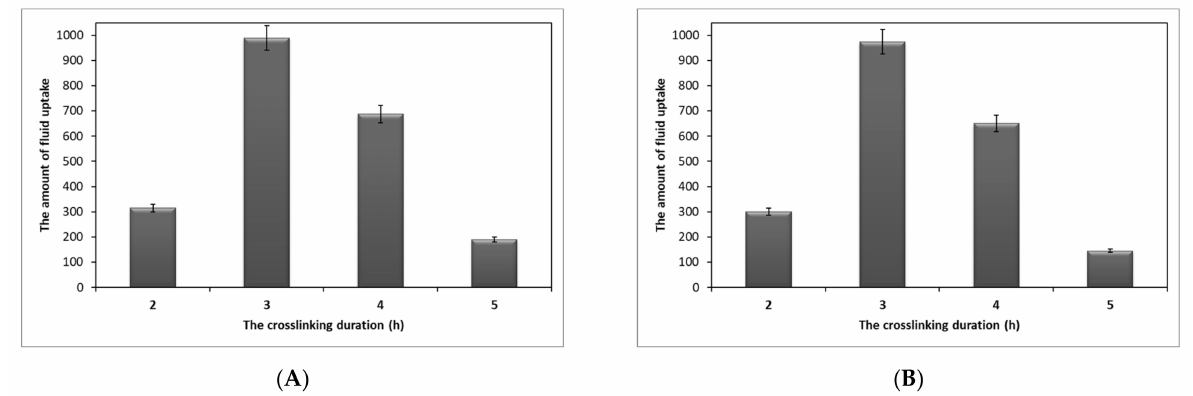
Figure 3. The amount of fluid uptake for PDDA/honey nanofiber composites at different crosslink- ing duration: ( A ) crosslinked PDDA/honey nanofiber composite (40/60) and ( B ) crosslinked PDDA/honey nanofiber composite